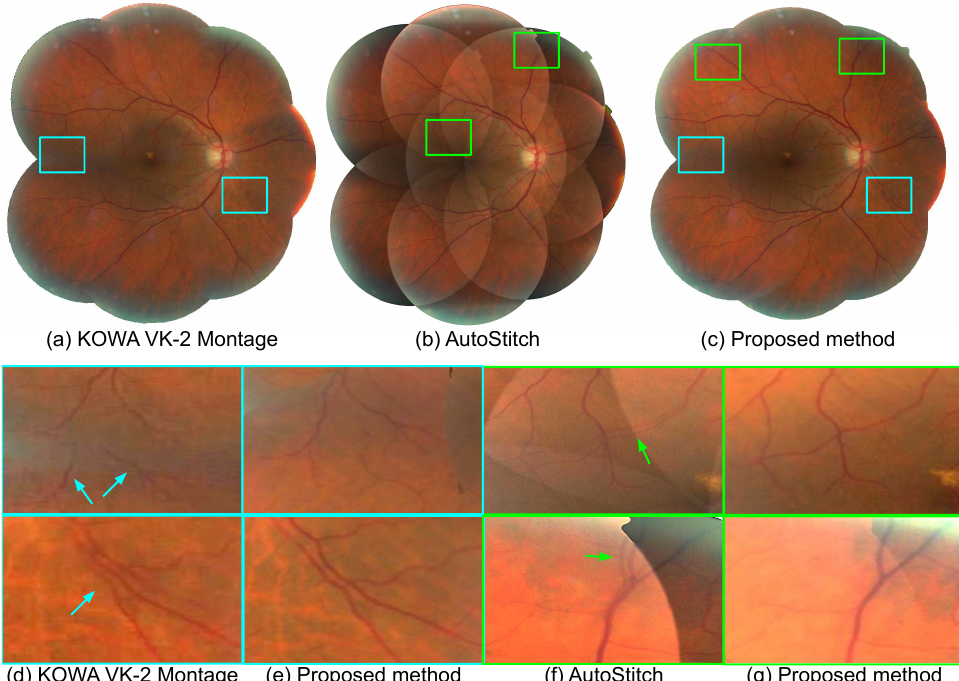
Figure 8. Retinal photomontages constructed by ( a ) the montage function of KOWA VK-2 [29], ( b ) AutoStitch [30], and ( c ) the proposed method, respectively. Local regions highlighted as boxes in ( a – c ) are enlarged in ( d – g ). ( d ) and ( f ) show the comparison between KOWA VK-2 montage and the proposed method, and ( e , g ) show the comparison between AutoStitch and the proposed method, respectively.